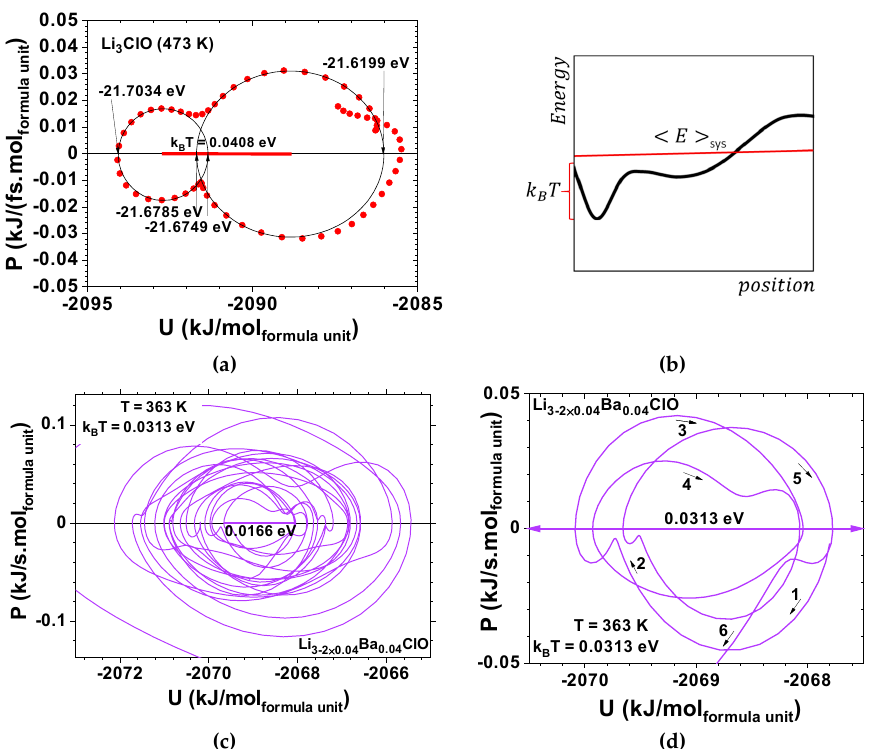
Figure 6. Ab Initio Molecular Dynamics for Li-glass ferroelectric-electrolytes showing decoherence; ( a ) inset of the phase portrait of Li 3 ClO showing a double-well potential; ( b ) schematic representation of energy vs position, showing that thermal excitation allows a molecule to hop back and forth between the wells; ( c , d ) insets of the phase portrait of Li 2.92 Ba 0.04 ClO showing back and forth paths between the wells described by a van der Pol-Duffing oscillator model as the one in Figures 1f and 2d. Note: Potential energy is dU = − F . dr and power is dP = F . dv where F is an applied force, r atom displacement, and v atom velocity.